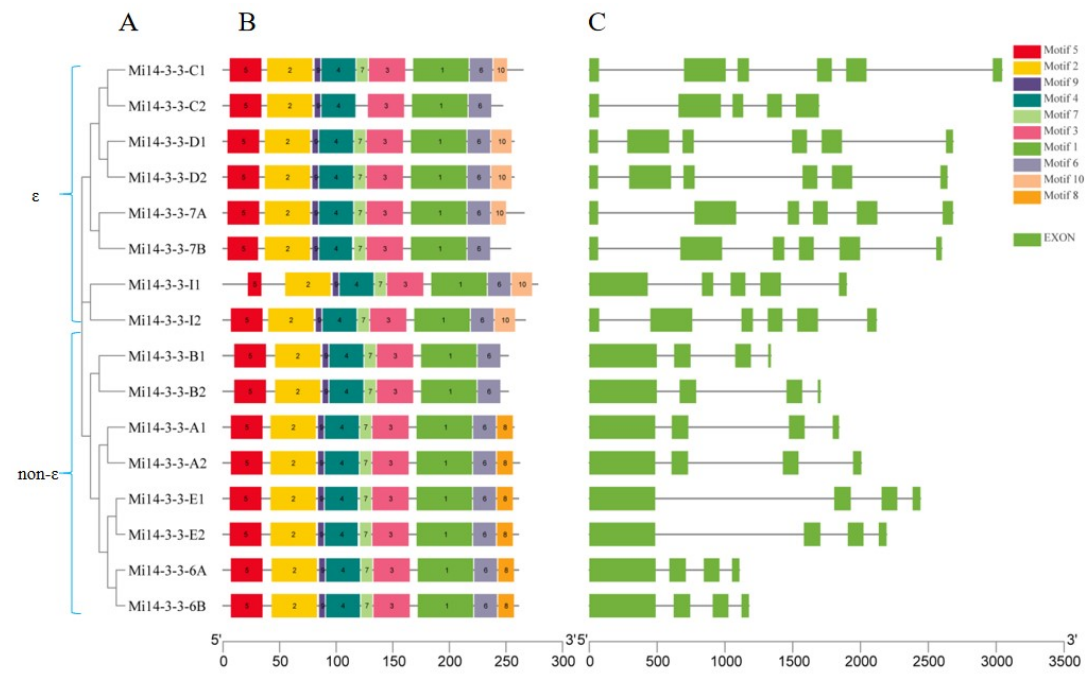
Figure 3. Phylogenetic relationships, gene structure and conserved motifs of the Mi14-3-3 genes. ( A ) Construction of a rootless neighbour-joining phylogenetic tree comprising 16 Mi14-3-3 gene sequences. ( B ) Distribution of conserved motifs within the 14-3-3 gene sequences. The differently coloured boxes represent different bases, and the motif numbers of the genes are shown in the coloured boxes. ( C ) Exon/intron structures of Mi14-3-3 genes. The green boxes represent exons, and the same-length black lines represent introns. The lengths of the exons can be inferred from the scale at the bottom.